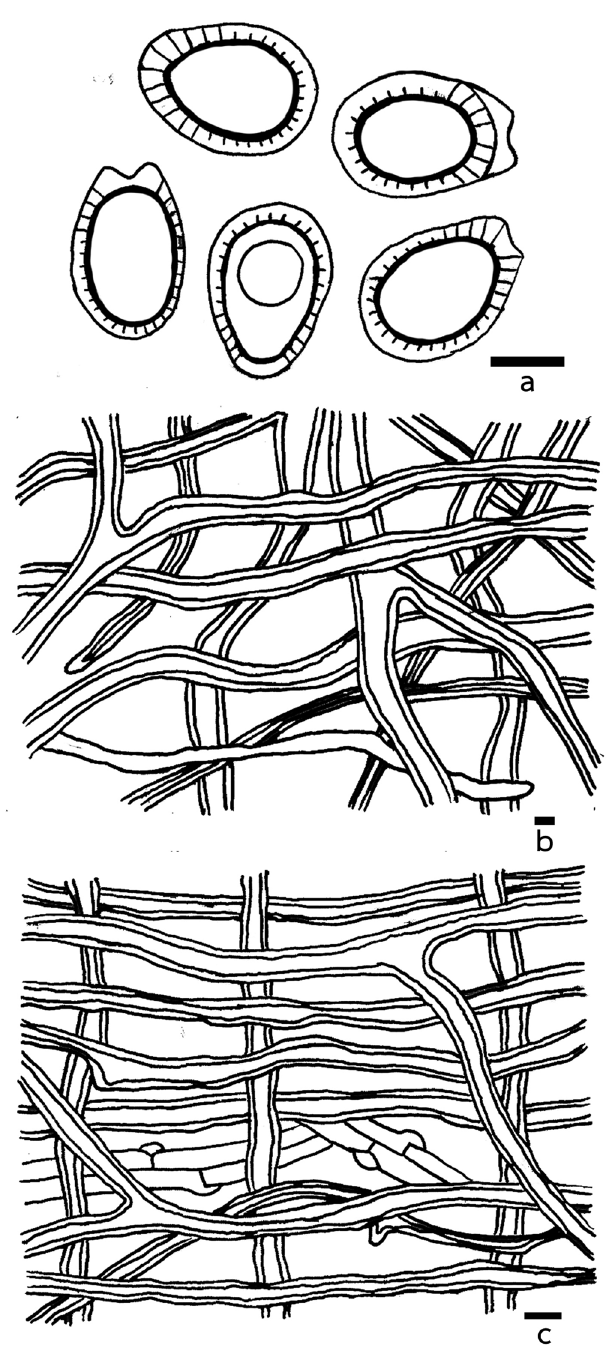
Figure 3. Microscopic structures of Ganoderma sichuanense (MFU 16-2668) A basidiospores B hyphae from trama C hyphae from context. Scale bars: 5